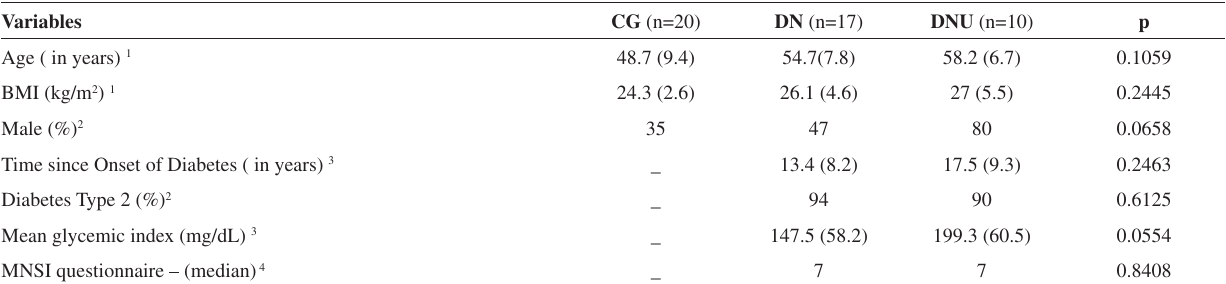
Table 1 - Demographic Data: Control Group (CG), Diabetic Neuropathy (DN) and Ulcerated Diabetic Neuropathy (DNU) Groups